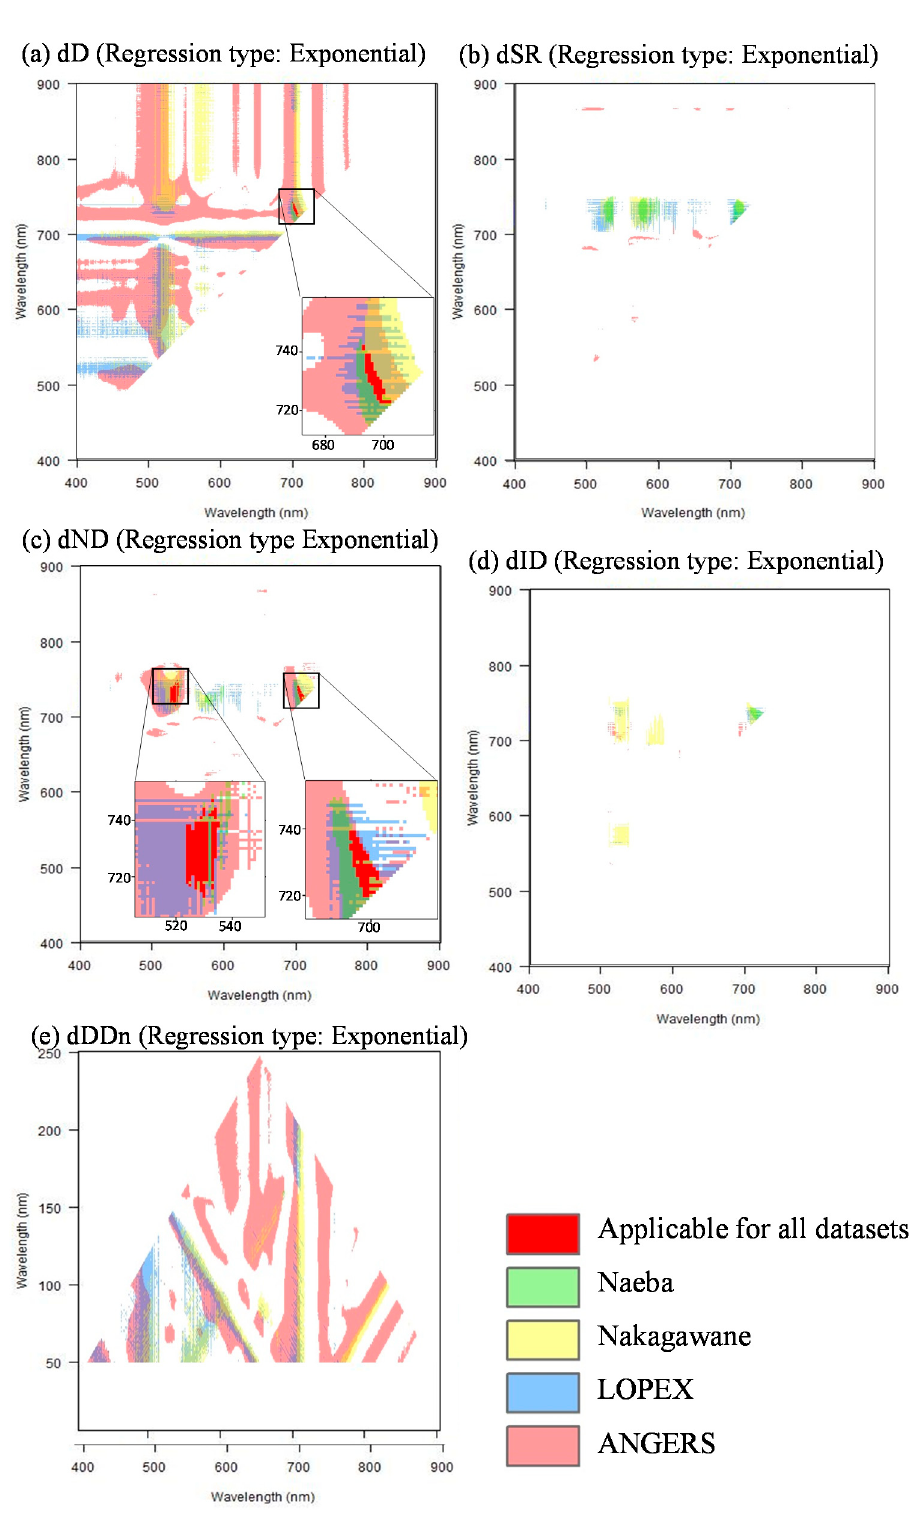
Figure 7. Categories based on RPD with different types of indices using first-order derivative spectra (exponential regression).